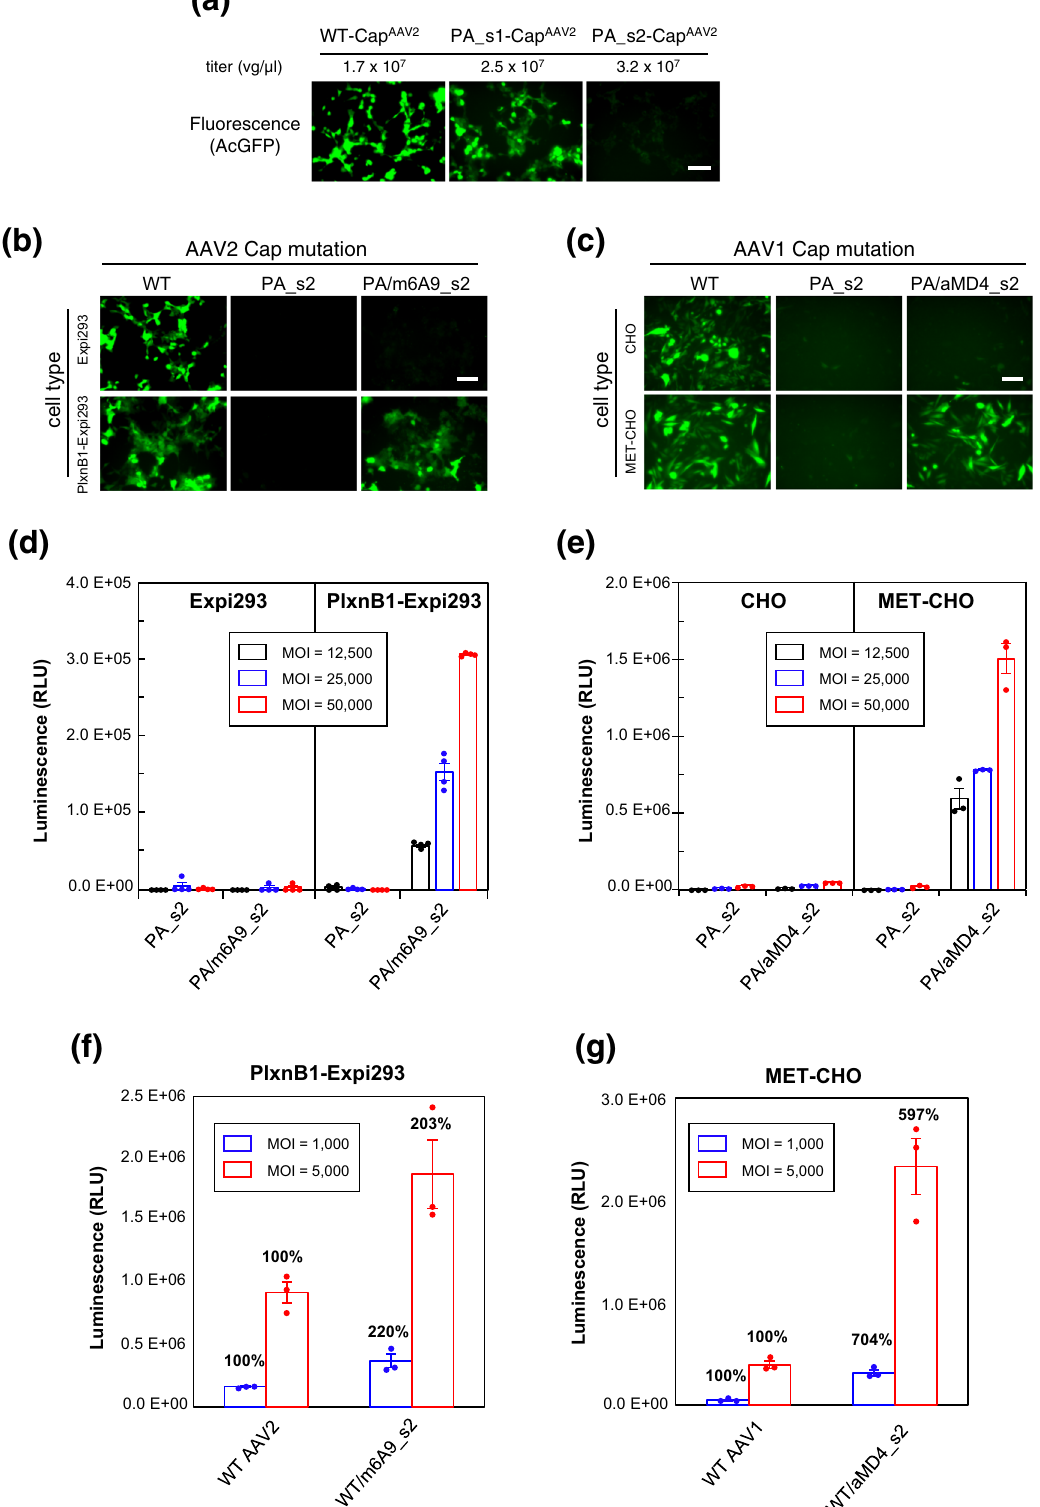
stably expressed human PlxnB1 (Fig. 6b), while no detectable AcGFP expression was observed with the parent cell line after incubation with the chimeric virus. We next expanded this ana- lysis to another AAV serotype (AAV1) using MET-binding aMD4 peptide as the targeting moiety. Unmodi fi ed AAV1 capsid was capable of transducing both Chinese hamster ovary